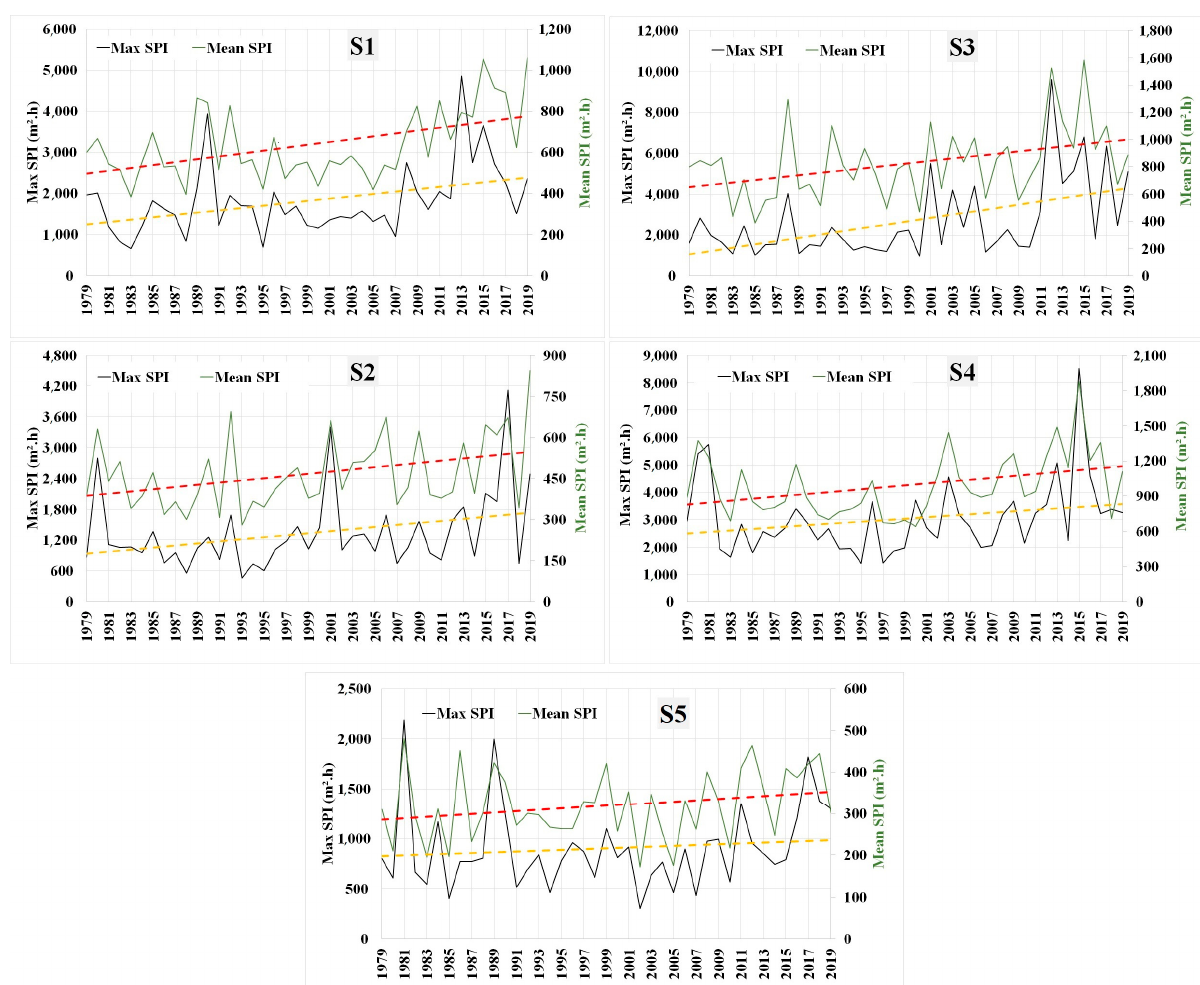
Figure 9. Time series plots of annual average and maximum SPI between 1979 and 2019 in five different locations of the Mediterranean Sea that have experienced the significant trend during this period. The dashed line shows the linear trend of each time series. The discontinued line illustrates the estimated Theil–Sen slope adjusted to the corresponding time series